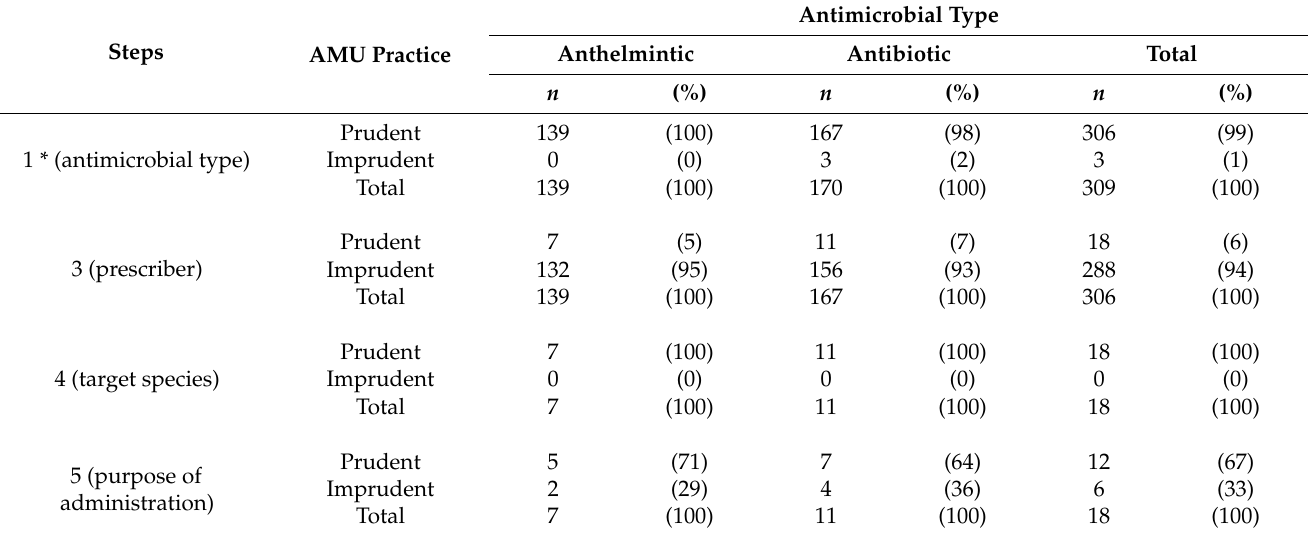
Table 1. Categorisation of 309 incidents where antimicrobials were used in livestock enterprises located in Viti Levu,